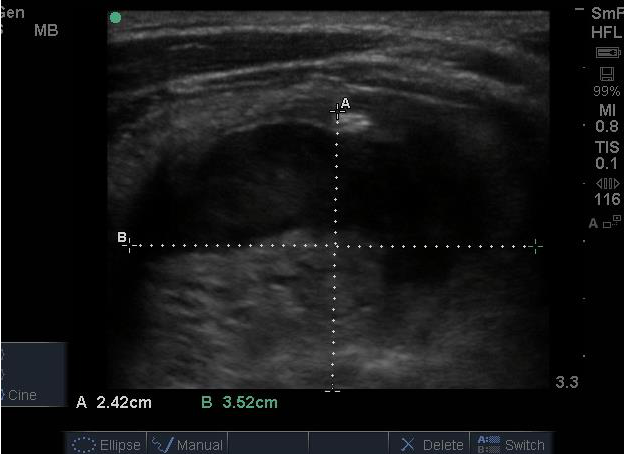
Figure 6. Large thyroid nodule of mixed appearance, i.e., comprising both solid (lower half) and cystic (upper half) components. FNAB of the solid component showed that the lesion was benign, whereas biopsy of the upper region obtained a large amount of chocolate coloured fluid.